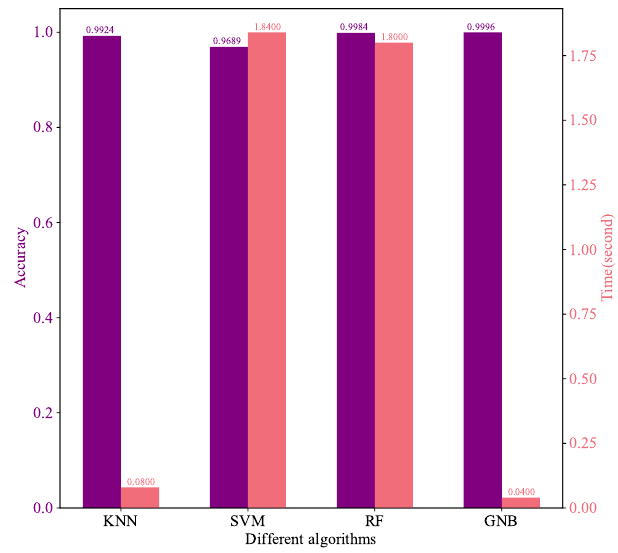
Figure 5. Performance comparison between different